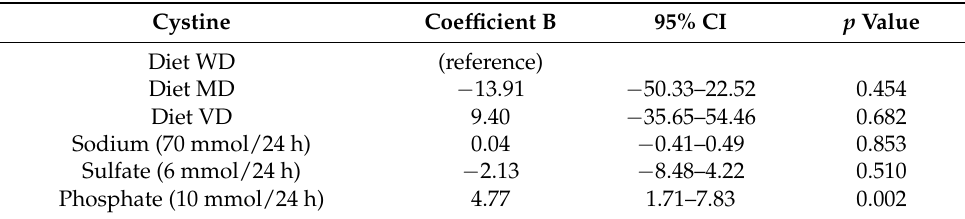
Figure 2. Association of 24 h urinary cystine excretion and suggested urinary risk factors for cystine stone formation ( a ) Urinary phosphate excretion; ( b ) Urinary sulfate excretion; ( c ) Urinary sodium excretion. Abbreviations: WD, Western-type diet; MD, balanced mixed diet; VD, balanced lacto-ovo-vegetarian diet. Table 3. Univariate associations of different diets and 24 h urinary parameters with urinary cys- tine excretion.